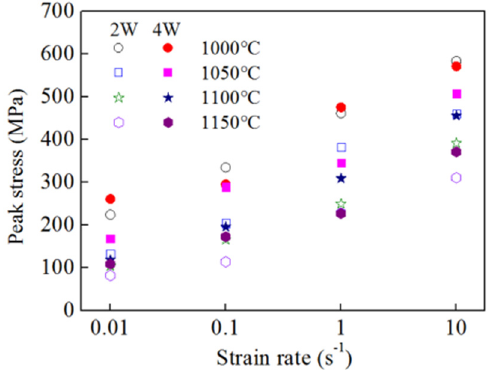
Figure 4. Peak stress at different strain rates.